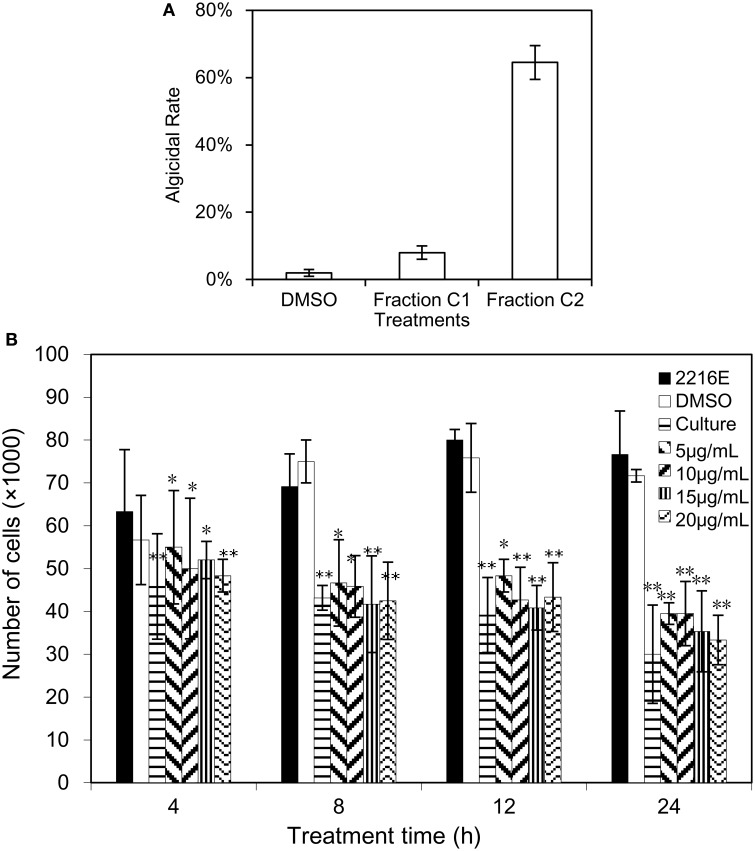
Algicidal assay of fraction C2 and (2-isobutoxyphenyl)amine. (A) The algicidal effect of fraction C2 on A. tamarense; (B) the algicidal activity of bacterial culture and (2-isobutoxyphenyl)amine on A. tamarense. All error bars correspond to the standard deviation. *Represents a statistically significant difference of p < 0.05 compared to the control, and **Represents a statistically significant difference of p < 0.01.